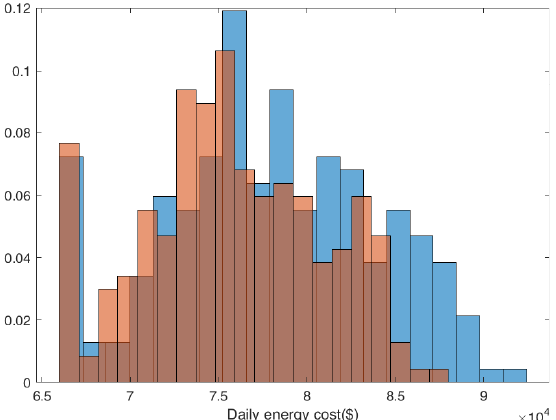
Figure 8. Histogram of daily energy cost of the micro-grid under standard (blue) and optimal (orange) EMS for the EV fleet.